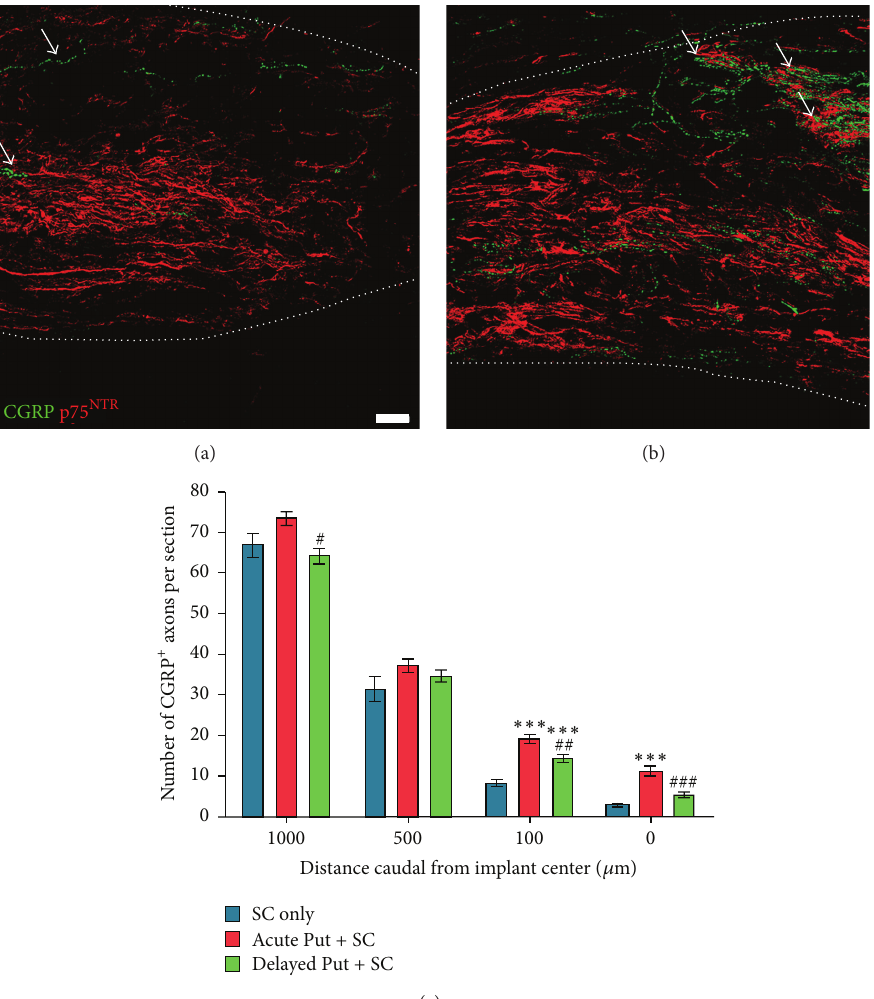
Figure 5: Putrescine administration increases peptidergic axon numbers within the SC implant. Immunochemical staining for peptidergic axons with CGRP (green, representative examples indicated by white arrows) shows that many more axons are present within SC implants (p75labeling,red)following(b)acuteputrescinedeliverycomparedto(a)whenvehicleisgiven.Scalebar=20 𝜇 m.Dottedwhitelinesindicate the extent of the SC implant. (c) Stereological analysis revealed a significant increase in CGRP + axon numbers with putrescine: the greatest effects are observed within the SC implants with acute putrescine administration. Statistical significance indicated at ∗∗∗ 𝑝 < 0.001 compared to the vehicle control group and # 𝑝 < 0.05 , ## 𝑝 < 0.01 , and ### 𝑝 < 0.001 compared to acute putrescine